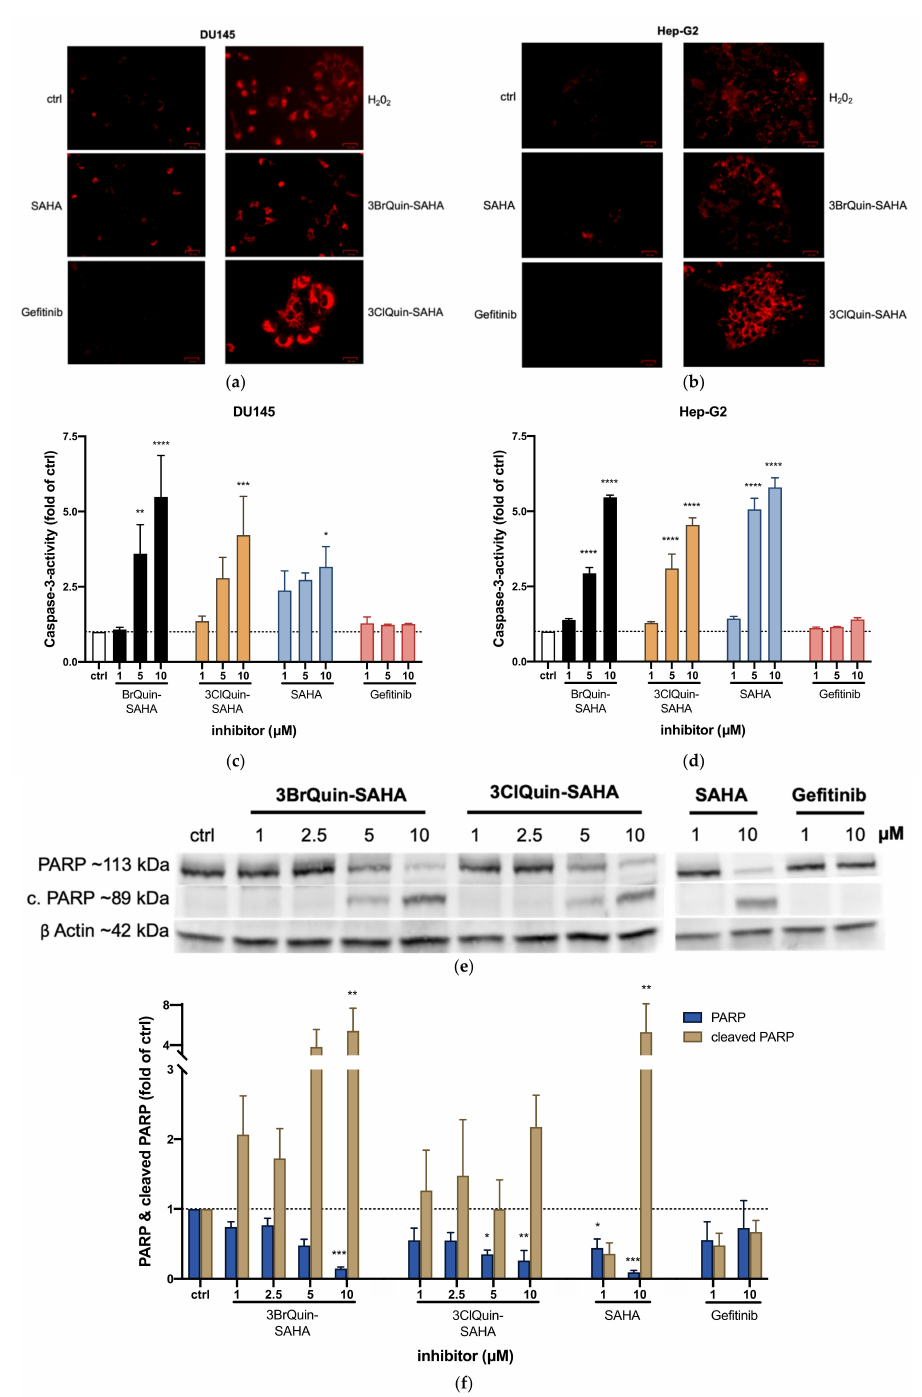
Figure 6. Apoptosis induction by 3BrQuin-SAHA and 3ClQuin-SAHA. ROS induction after 24 h of incubation with 10 µ M 3BrQuin-SAHA, 3ClQuin-SAHA, SAHA, and gefitinib in DU145 ( a ) and for Hep-G2 cells ( b ). H 2 O 2 (1.6 mM) was used as positive control. Representative findings out of n = 3 independent experiments. Caspase-3 induction in DU145 ( c ) or Hep-G2 cells ( d ) after 24 h treatment with 3BrQuin-SAHA, 3ClQuin-SAHA, SAHA, and gefitinib. Means ± SEM of n = 3 independent experiments. ( e ) Representative Western blot out of n = 3 experiments, showing changes in the expression PARP and PARP after cleavage in DU145 cells after 24 h treatment with compound. ( f ) Out of these Western blots’ gray intensities, PARP- and cleaved-PARP-specific bands were quantified, adjusted to protein-loading, and normalized to untreated controls. Data are given as means ± SEM of n = 3 independent experiments. * p ≤ 0.05, ** p ≤ 0.005, *** p ≤ 0.0005, **** p ≤ 0.0001; two-way ANOVA Dunnett’s post hoc